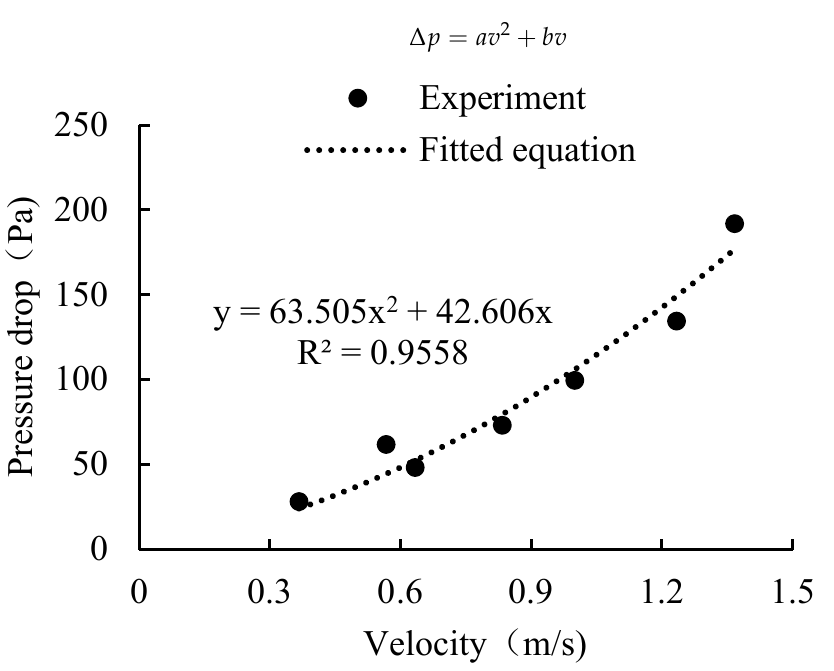
Figure 8. Fitted equation of the porous parameters.